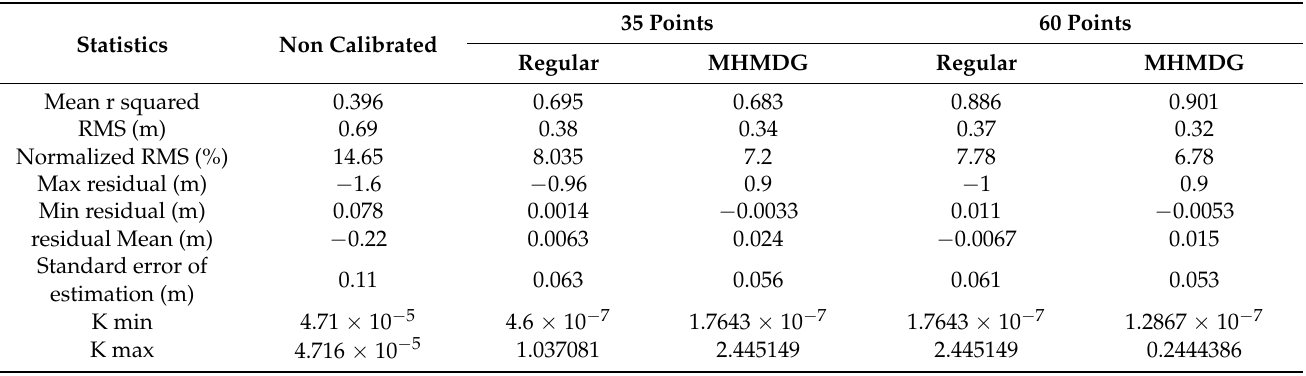
Table 2. Statistic of the simulation over 35 parameters and 60 parameters in regular and MHMDG pilot point